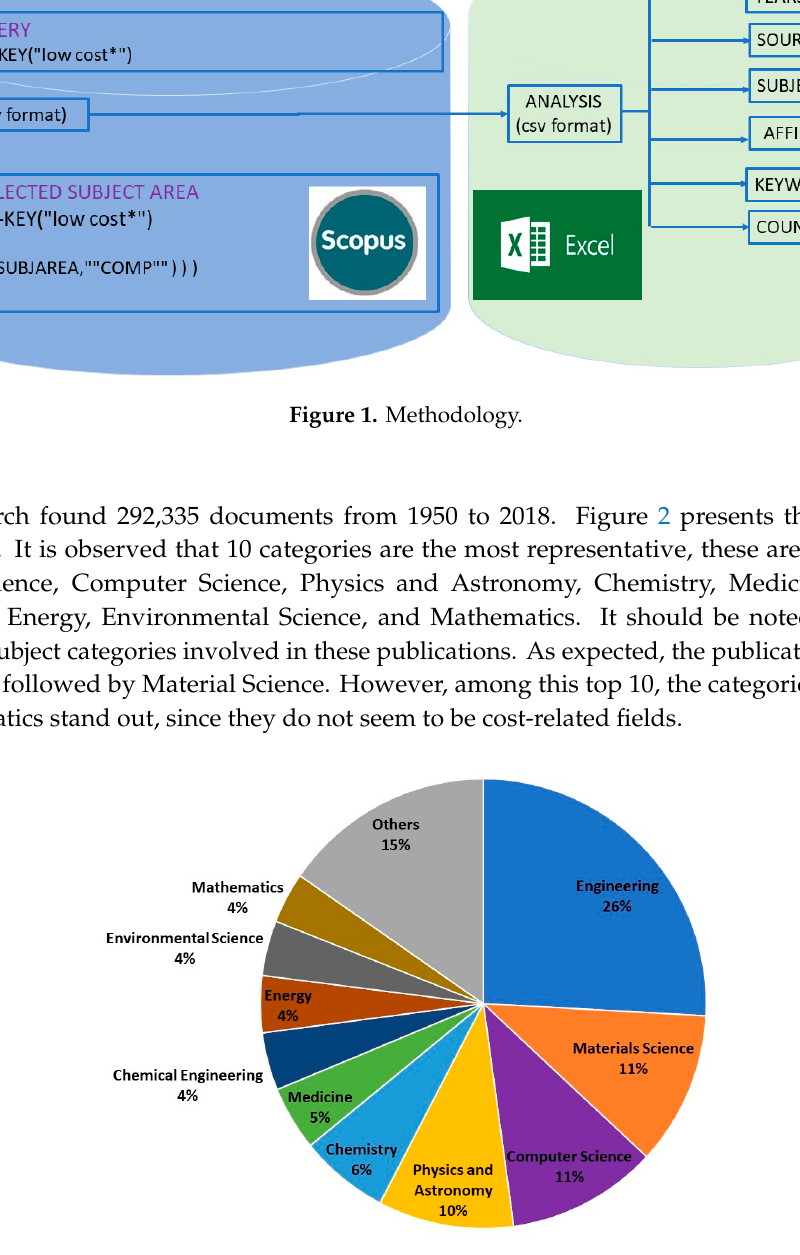
Figure 3. Temporal evolution of low-cost publications by scientific categories indexed in Scopus. 3.1. Types of Publications Analyzing the type of publication according to the indexation category, the following can be found: Abstract Report, Article, Book, Book Chapter, Business Article, Conference Paper, Conference